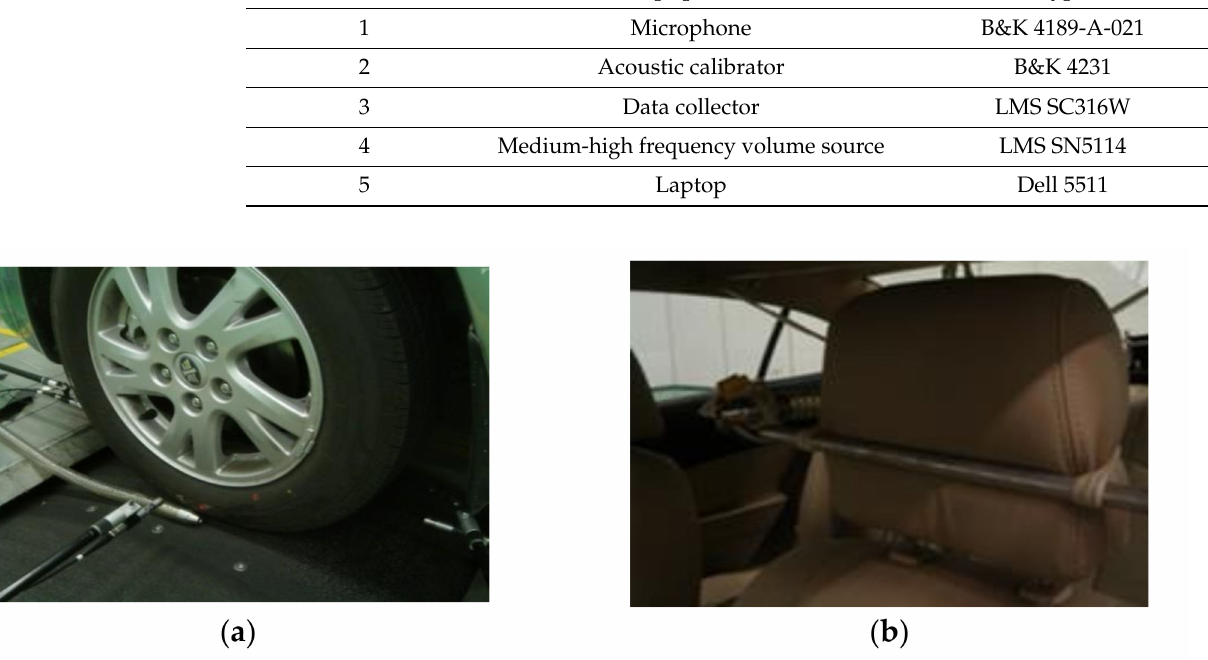
Figure 5. Measurement position of noise transfer path function of the left front tire: Layouts of ( a ) the microphone and volume sound source at the left front tire and ( b ) the microphone placed at the driver’s right ear.